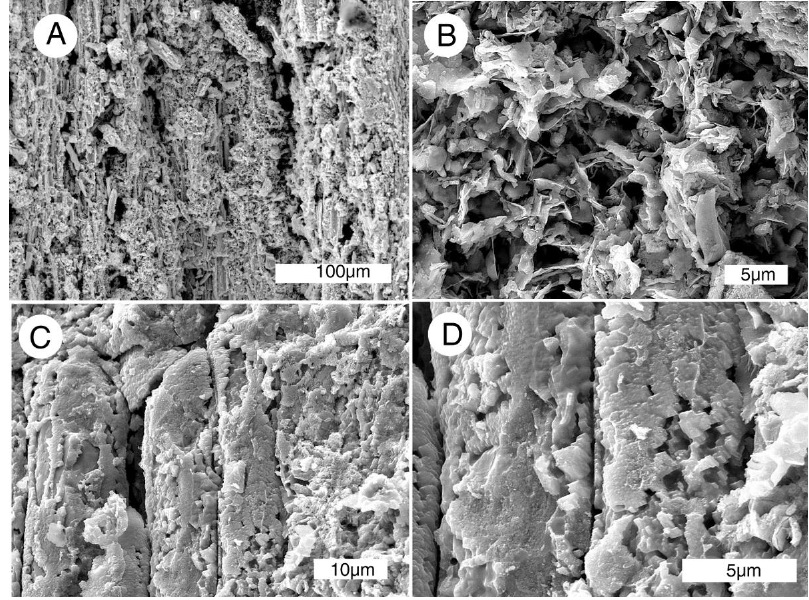
Figure 14. SEM radial views of Miocene wood mineralized with Mn-Fe, Virgin Valley, Nevada, USA, specimen in Figure 7C. ( A , B ) Tracheids mineralization showing flake-like morphology; ( C , D ) tracheids mineralized with blocky mineral particles. Table 5. SEM/EDS data for Mn-Fe oxide fossil wood from Virgin Valley, Nevada,